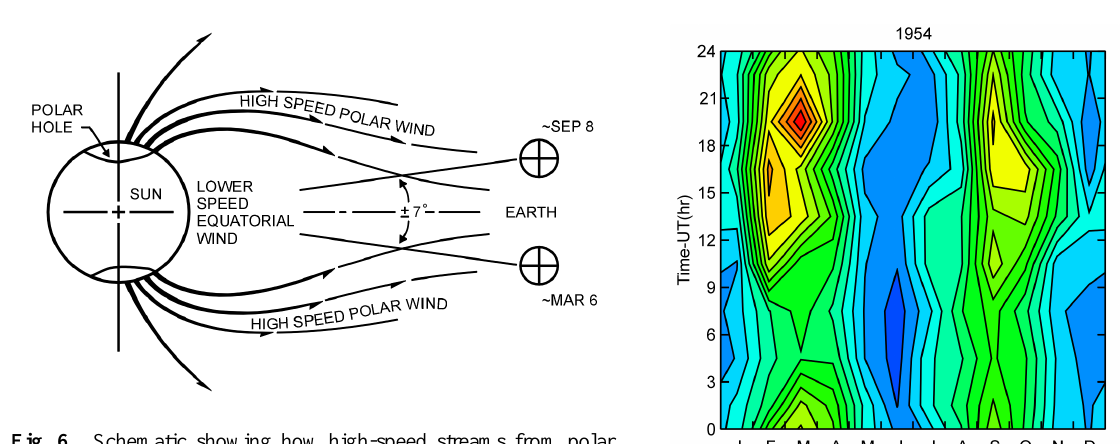
Fig. 6. Schematic showing how high-speed streams from polar coronal holes can contribute to the semiannual variation of geomag- netic activity via an axial effect (after Bohlin, 1977).